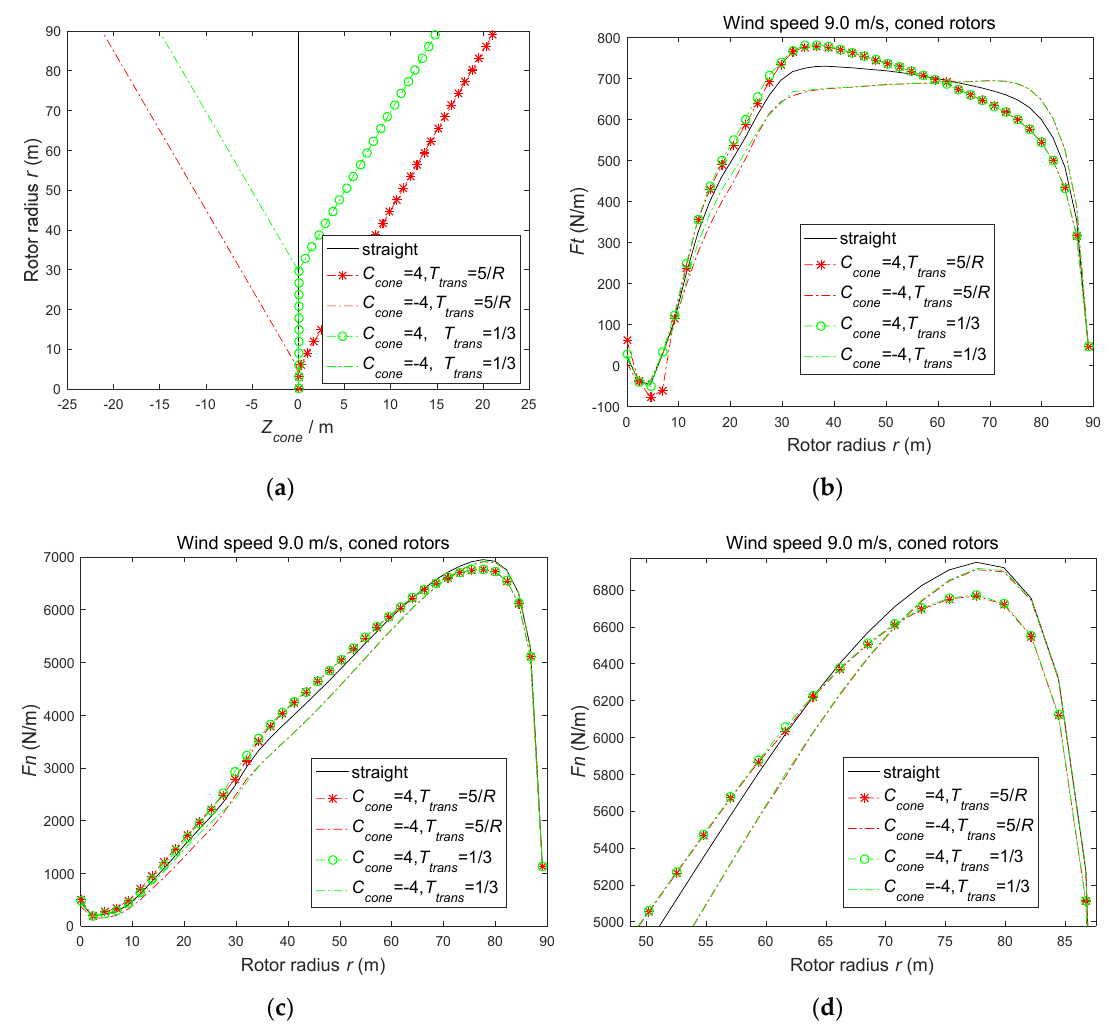
Figure 9. Comparisons of rotors with T trans = 5/ R , 1/3: ( a ) conning configurations; ( b ) tangential force; ( c ) normal force; ( d ) magnified view of normal force. (2) Rotors with T trans = 1/3, 2/3.